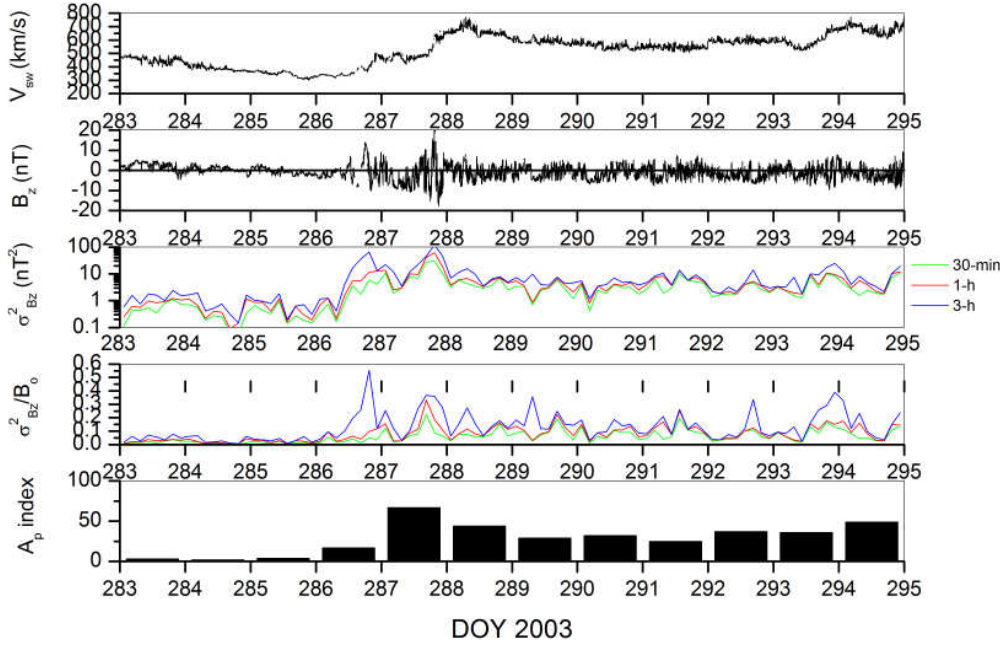
Fig. 5. The same format as in Fig. 4, but for a high speed stream interval during the declining phase of the solar cycle, day 283–295,